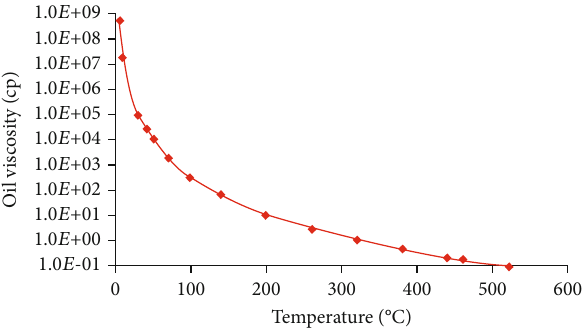
Figure 5: Oil viscosity versus temperature for numerical simulation in this